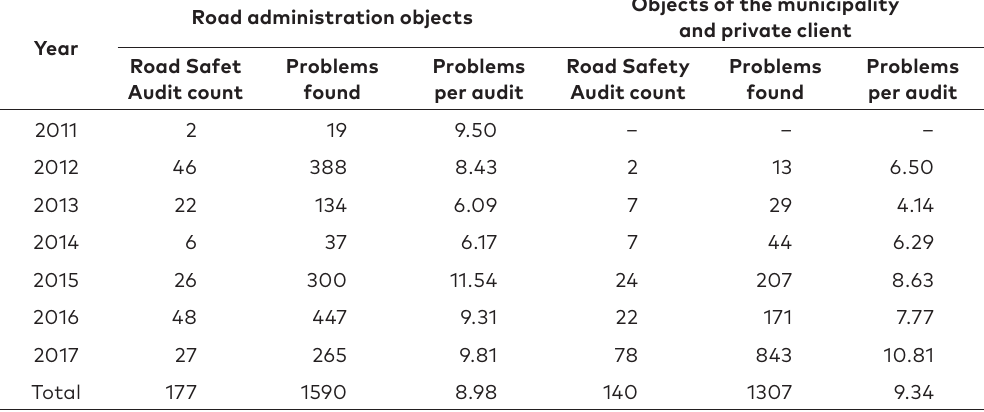
Table 2. Road Safety Audit distribution by year divided by object